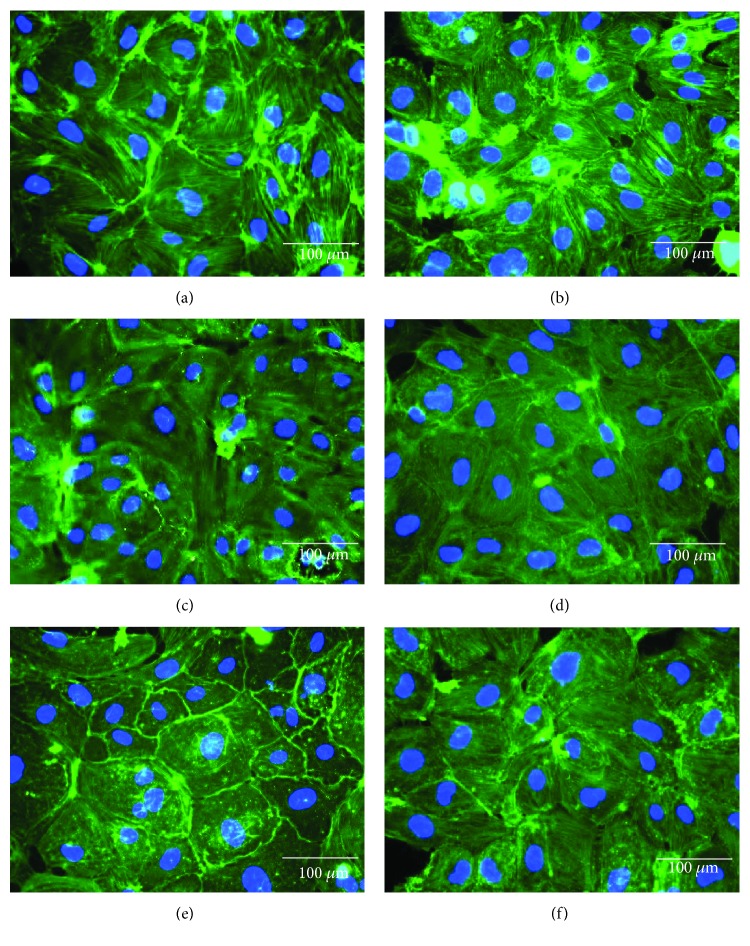
Effect of HUVECs pretreated with TH on H2O2-induced cytoskeletal remodeling and gap formation. Actin cytoskeleton (green) is shown merged with its nucleus (blue) stained with DAPI. Representative images were taken from one of three independent experiments at 400x magnification. Merged images were generated with Olympus BX-51 Cell-F imaging software. Images represent basal (a); H2O2 at 0.5 mM (b); and pretreatments+inducer: TH 0.01%+H2O2 (c), TH 0.10%+H2O2 (d), TH 1.00%+H2O2 (e), and TR+H2O2 (f). Basal = untreated; TH = Tualang honey; TR = Trolox.